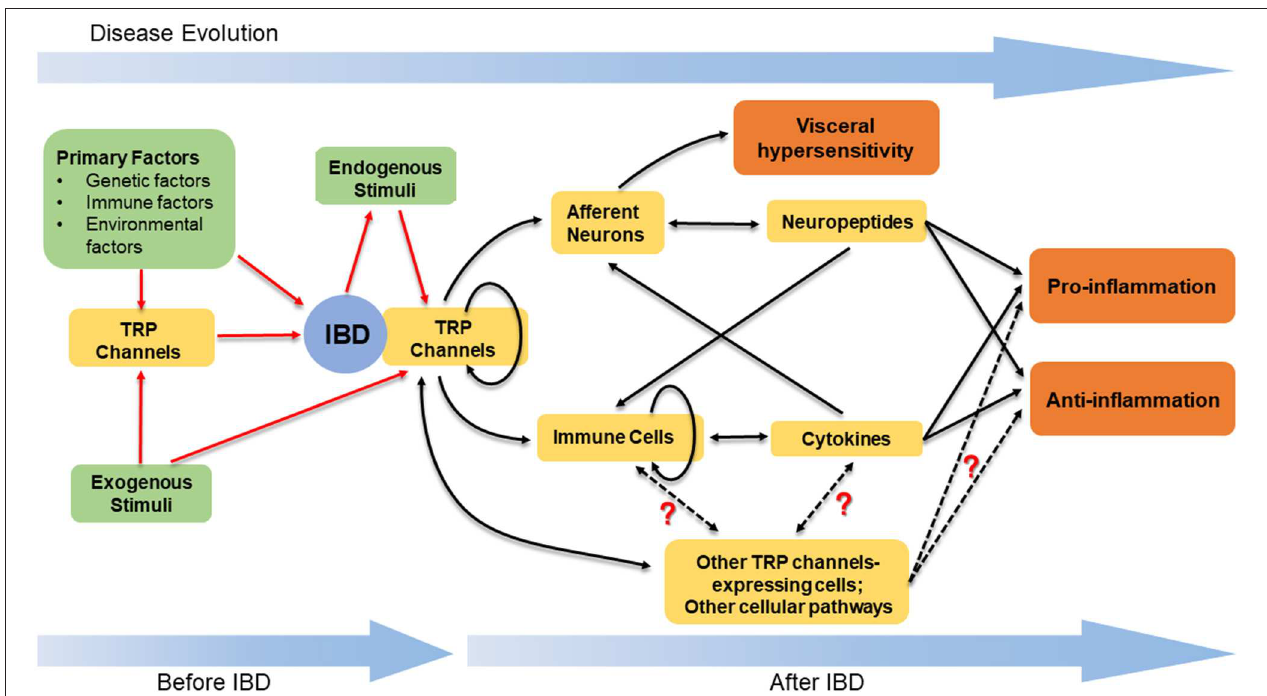
FIGURE 2 | The stimulation of TRP channels and the downstream regulatory network in IBD. TRP channels, together with other primary factors, play a role in the pathogenesis of IBD. The stimulation of TRP channels is based on the exogenous stimuli and the endogenous stimuli. The latter mainly refer to the mediators synthesized and released within the progress of colitis. The activated TRP channels can induce the release of neuropeptides and cytokines, thus leading to the pro- or anti-inflammatory effects. In addition to neurons and immune cells, there are other TRP channels-expressing cells and cellular pathways contributing to regulate the intestinal inflammation, while the definite functions of these cells and pathways are unclear. The complicated crosstalk amongst the neuropeptides, cytokines, TRP channels-expressing cells, and diverse cellular pathways results in the various but elusive effects induced by the stimulation of TRP channels in IBD.